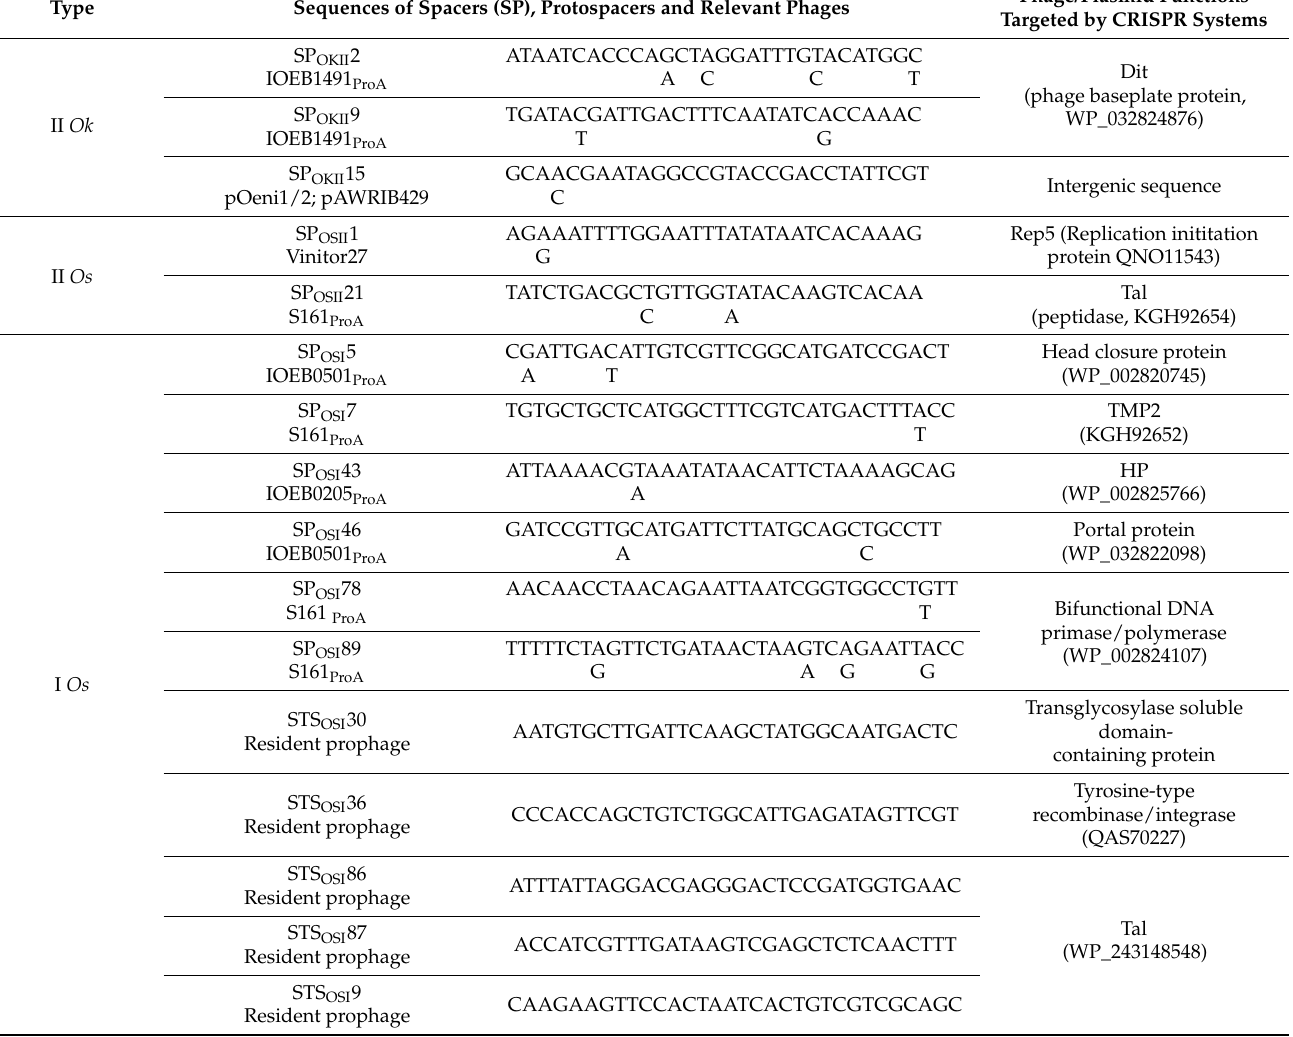
Table 2. List of the unique protospacers found in MGE from Oenococcus sp. (phage or plasmid) and function of the genes targeted by CRISPR